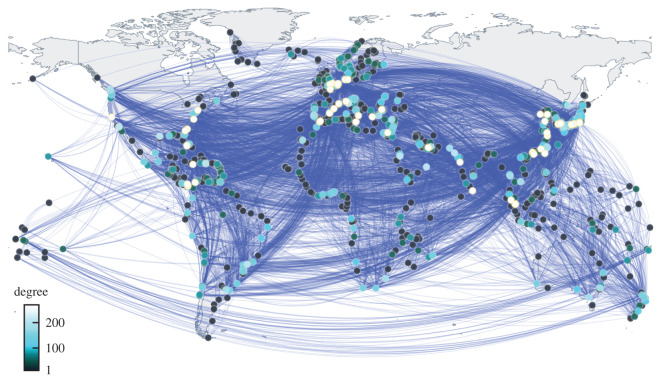
Unweighted GLSN. Ports with a large degree are represented by circles in a bright colour.